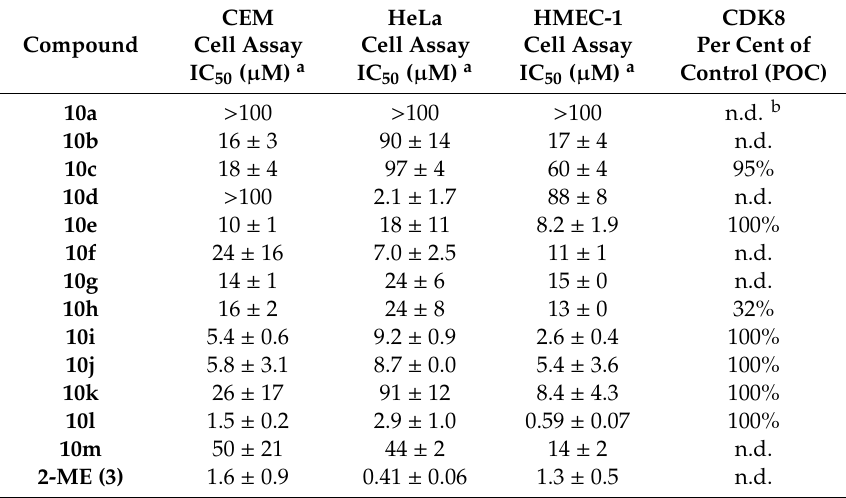
Table 1. Biological evaluation of compounds 10a–10m